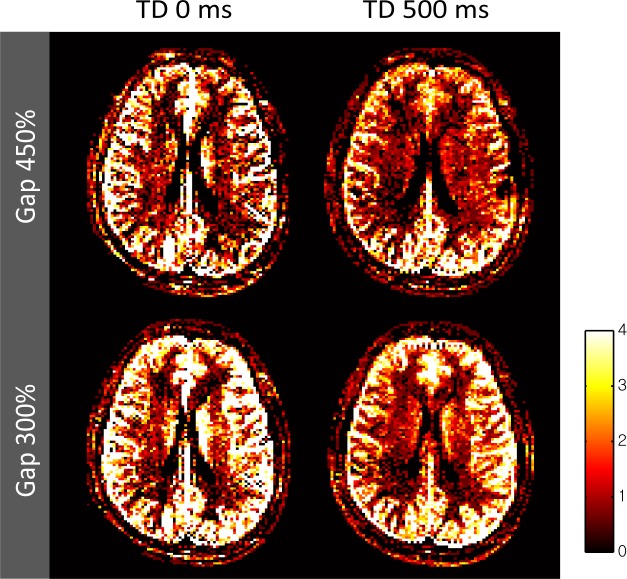
Representative arterial cerebral blood volume (aCBV) maps from the same subject as shown in Fig 6.The values in the color scale bar are displayed in the unit of mL/100 mL.